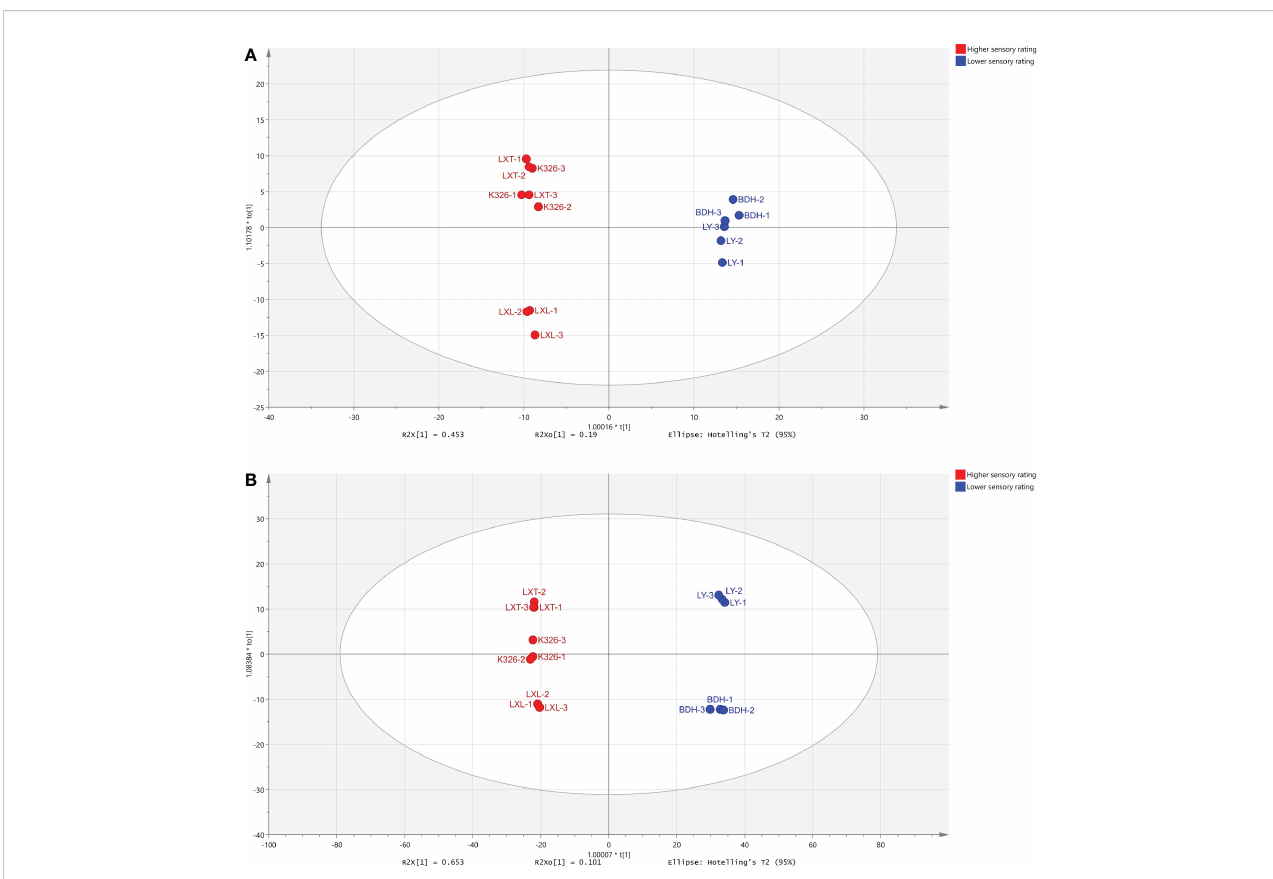
FIGURE 3 OPLS-DA performed on (A) 309 volatile metabolites and (B) 1168 non-volatile metabolites identi fi ed in fi ve tobacco varieties according to the higher and lower sensory ratings. The colors indicate the different levels of sensory ratings (red: higher sensory rating, blue: lower sensory